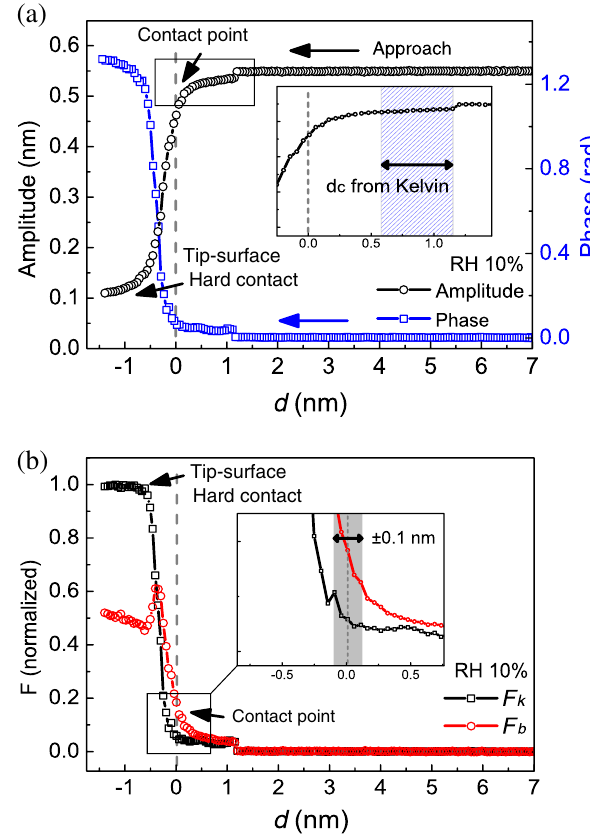
FIG. 3. (a) The tip-surface contact ( d ¼ 0 ) is determined as the point where a rapid decrease of the tip ’ s shear amplitude starts during approach. The inset shows that the critical distance calculated by the Kelvin equation (blue shaded region) is still much shorter than the shortest experimental value of d at 10% RH, even if the experimental error of contact-point determination [ (cid:2) 0 . 1 nm; see inset of (b)] is included. (b) The elastic and viscous forces derived by the corresponding ampli- tude-phase information [24], where the contact point can be equally